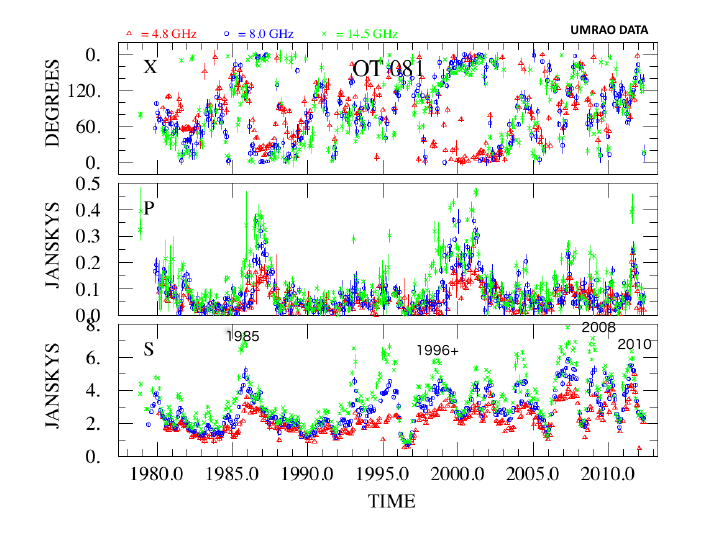
Figure 1. Longterm UMRAO light curves illustrate the range of variability in consecutive outbursts in the emission from the example program source OT 081 (1749 + 096). From bottom to top, 30-day averages of the total flux density (S), polarized flux (P), and electric vector position angle (EVPA or X) are shown. Green crosses, blue circles, and red triangles denote the data at 14.5, 8.0, and 4.8 GHz respectively. Modeled epochs are indicated with time labels in the lower panel.